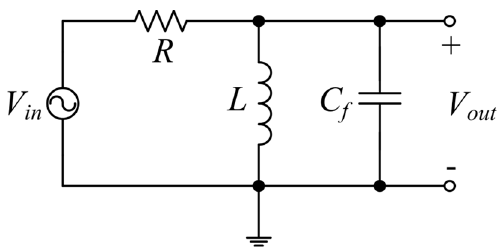
Figure 20. A second-order voltage-mode band-pass filter application.